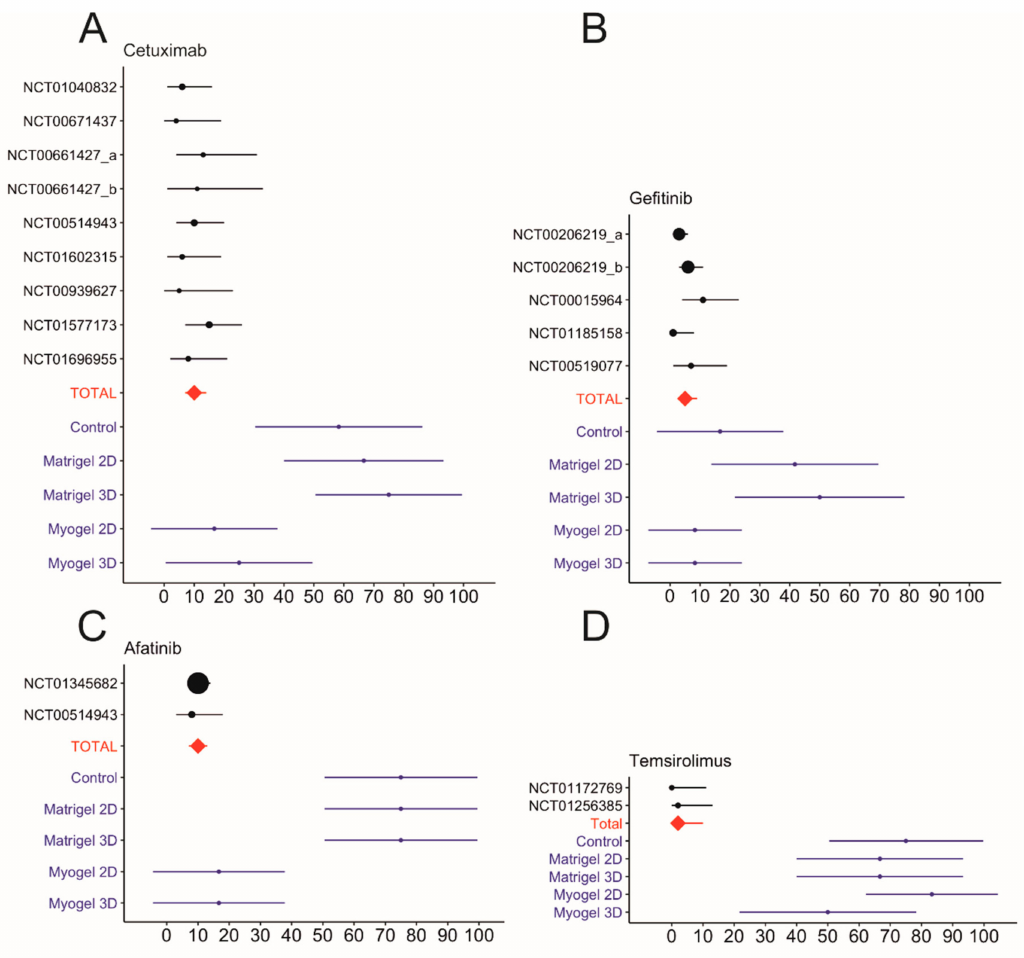
Figure 2. Meta-analysis of the objective response rates (ORRs) for cetuximab, gefitinib, afatinib, and temsirolimus monotherapy clinical trials and the response rates of in vitro drug testing. The pooled total average for the ORRs appears as a red diamond. The in vitro response rates were calculated using a drug-sensitivity score (DSS) value of ≥ 5 as the cut-o ff point ( A – D ). Data collected from https: // clinicaltrials.gov. The di ff erent doses used in the same trial are marked as a and